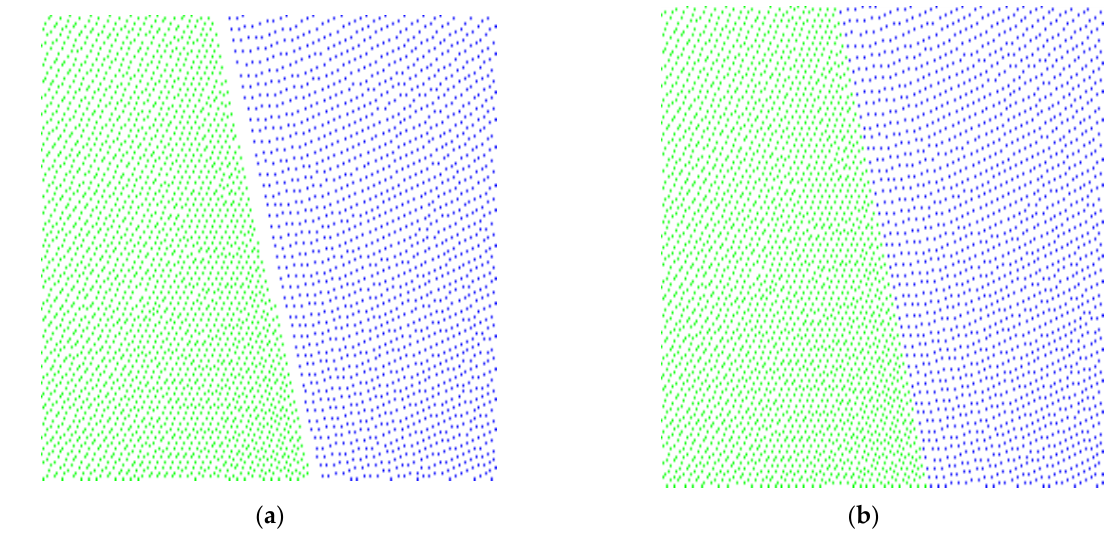
Figure 4. The distance threshold: ( a ) 0.020 m; ( b ) 0.025 m.